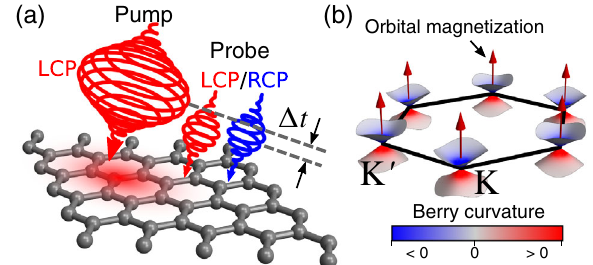
FIG. 1. (a) Sketch of a pump-probe TR-ARPES setup: A left- handed circularly polarized (LCP) pulse transiently dresses the electronic structure, which is probed by a right-handed circularly polarized (RCP), or LCP, short probe pulse. Delaying the probe pulse by Δ t with respect to the pump provides access to real-time dynamics. (b) The induced Floquet-Chern insulator is charac- terized by nonzero Berry curvature in the lower effective band with the same sign at the two inequivalent Dirac points. The resulting net orbital magnetization gives rise to circular dichroism in photoemission